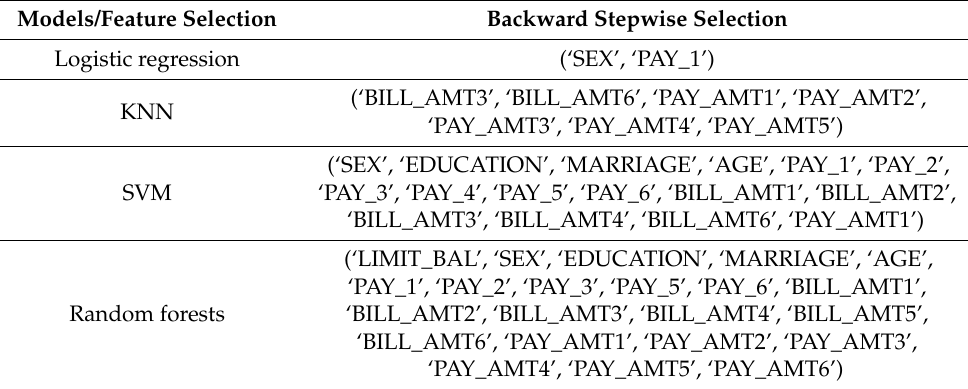
Table 6. The features selected by backward stepwise